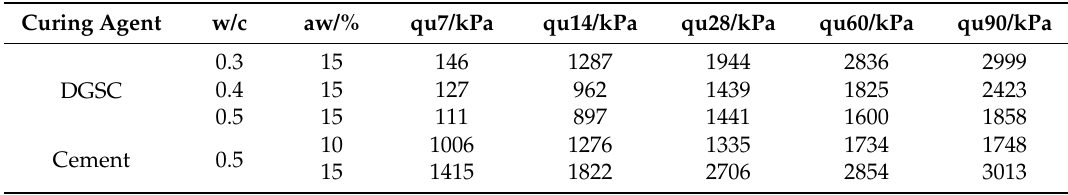
Figure 4. T-qu curves of the solidified clay under ( a ) 0.3, ( b ) 0.4, and ( c ) 0.5 of the water-binder ratio and ( d ) the comparison of cement and DGSC under 0.5 water-binder ratio. Table 7. The effect of the water-cement ratio on the strength of solidified soil.